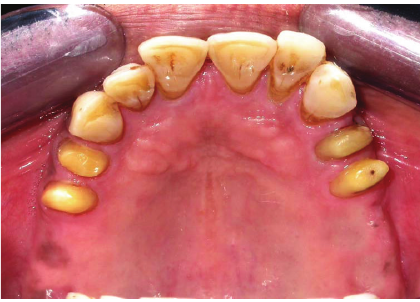
Figure 4: Try-in of the joint PFM crown with attachment.